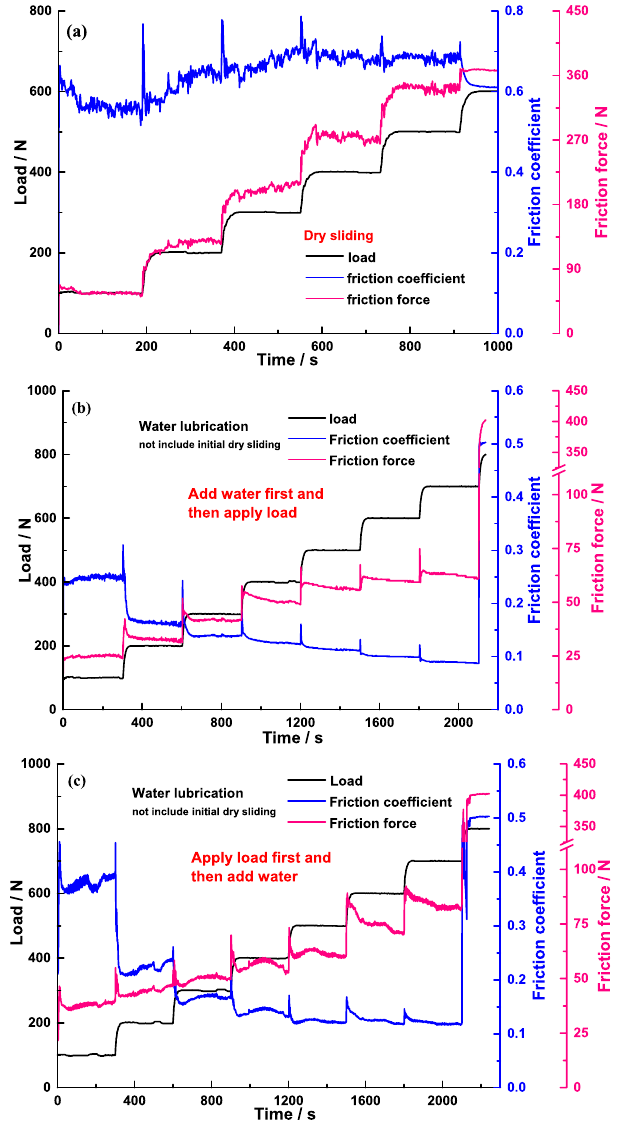
Figure 5. Variation of friction coefficient and friction force between SiC-SiC with running time under different external loads at a rate of rotation of 200 rpm, corresponding to 0.5 m/s, under different lubrication states: ( a ) dry friction, ( b ) water lubrication not including initial dry sliding, and according to the sequence of adding water first and then applying load, and ( c ) water lubrication not including initial dry sliding, and according to the sequence of applying load first then adding